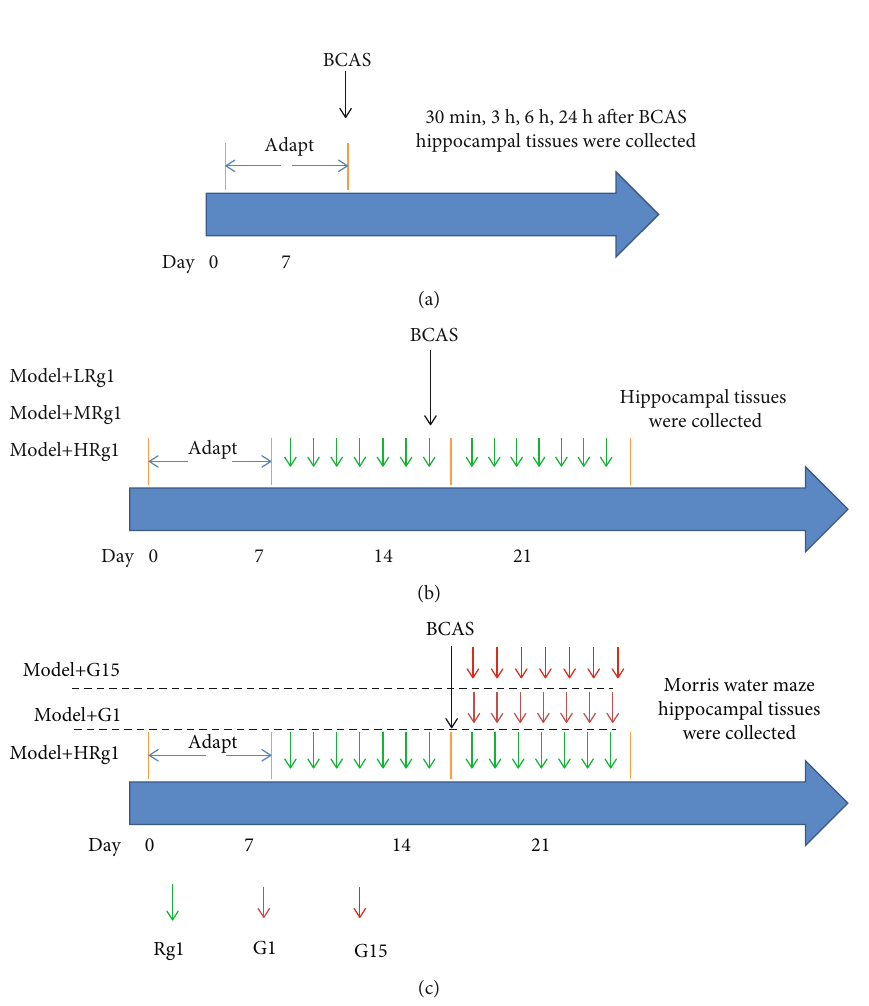
Figure 1: Schematic illustrates the study designs. (a) The mice were adapted for 7 days. Thereafter, BCAS was produced, and the hippocampal tissues were collected 30min, 3h, 6h, and 24h later. (b) The mice were adapted for 7 days. The mice in Rg1 groups received low, medium, and high doses of Rg1 for 14 consecutive days (one injection per day). Seven days after administration of Rg1, BCAS was produced in the mice. (c) The mice were adapted for 7 days. The mice in the Rg1 group received HRg1 for 14 consecutive days (one injection per day). Seven days after administration of Rg1, BCAS was produced in the mice. In the G1 and G15 groups, the mice received BCAS followed by G1 and G15, respectively. After treatments, Morris water maze was conducted. After the behavioral tests, the animals were decapitated following anesthesia with iso fl urane (5%) and the hippocampi were